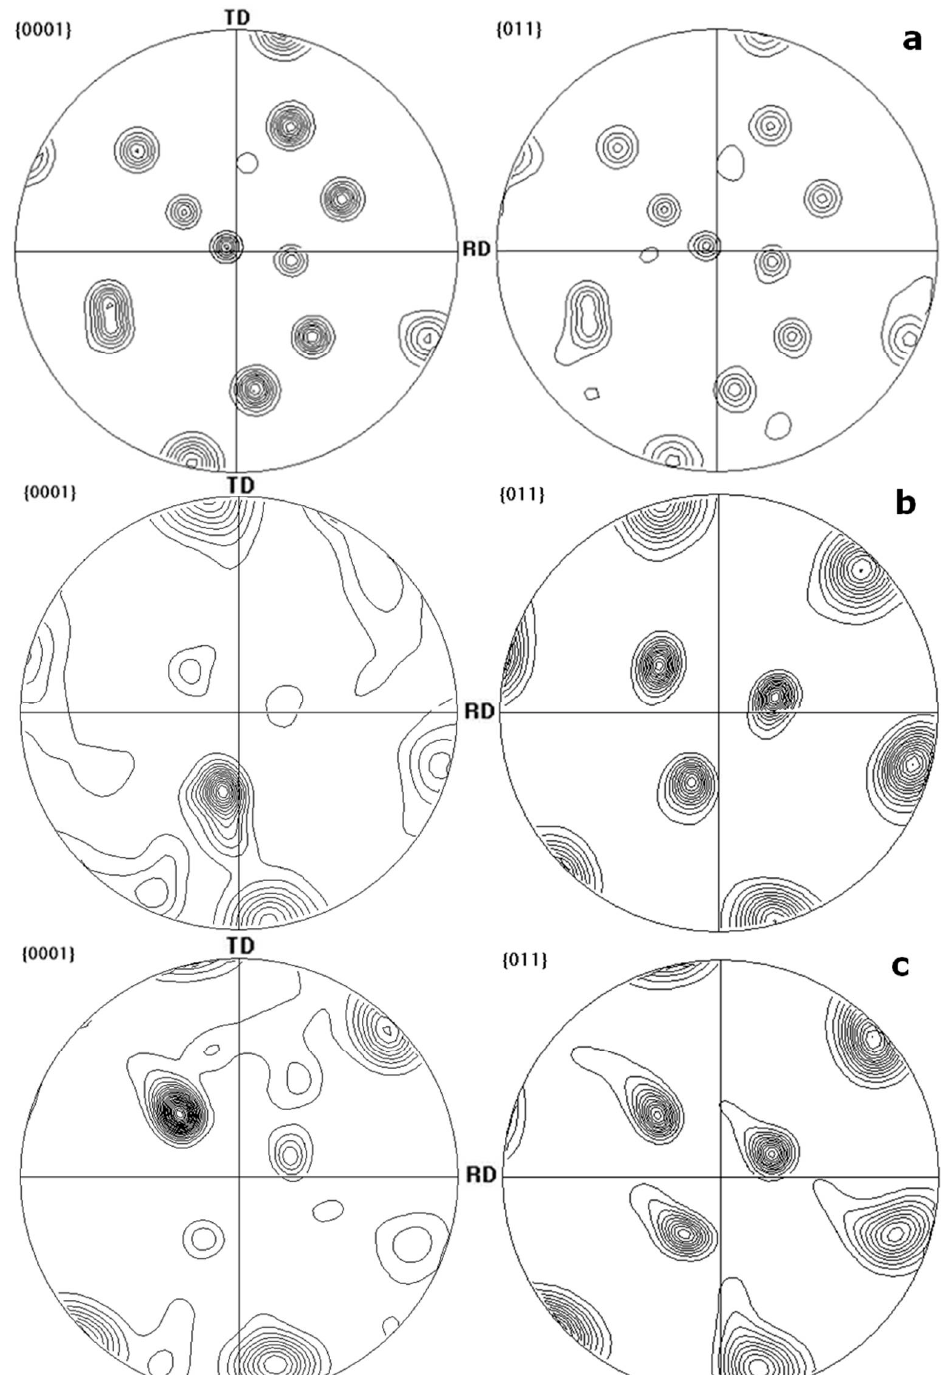
Figure 10. Pole figures of the ( a ) as-cast, ( b ) hot-rolled and ( c ) annealed β 20C alloys.